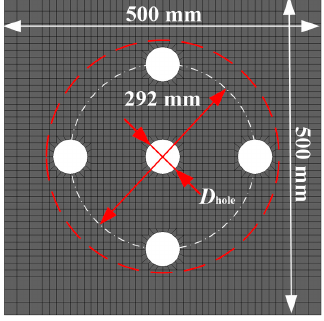
Figure 3. Sketch of rock models: D hole = 35, 45, 55, and 65 mm.